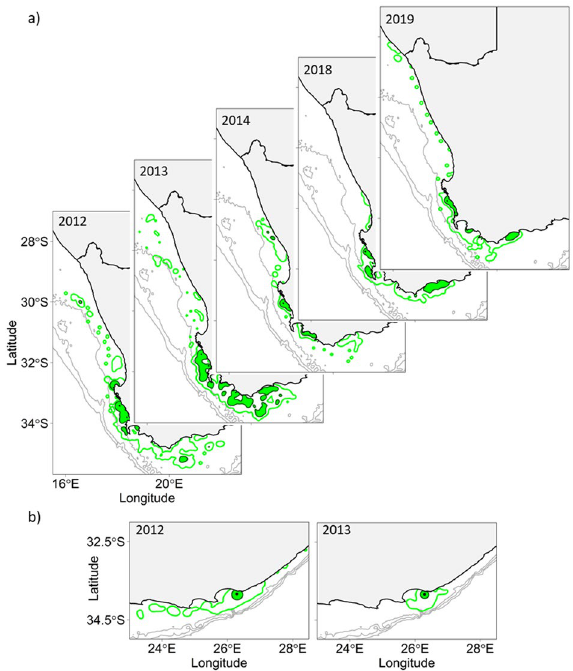
Figure 2. Annual distributional (90% utilisation distribution—UD, open polygon) and core ranges (54% UD, shaded area) of African penguins tagged at ( a ) Dassen Island and ( b ) Bird Island during their pre-moult foraging trips to the 200, 500 and 1000 m isobaths (grey lines). Annual distributional and core ranges were only calculated when > 5 individuals were